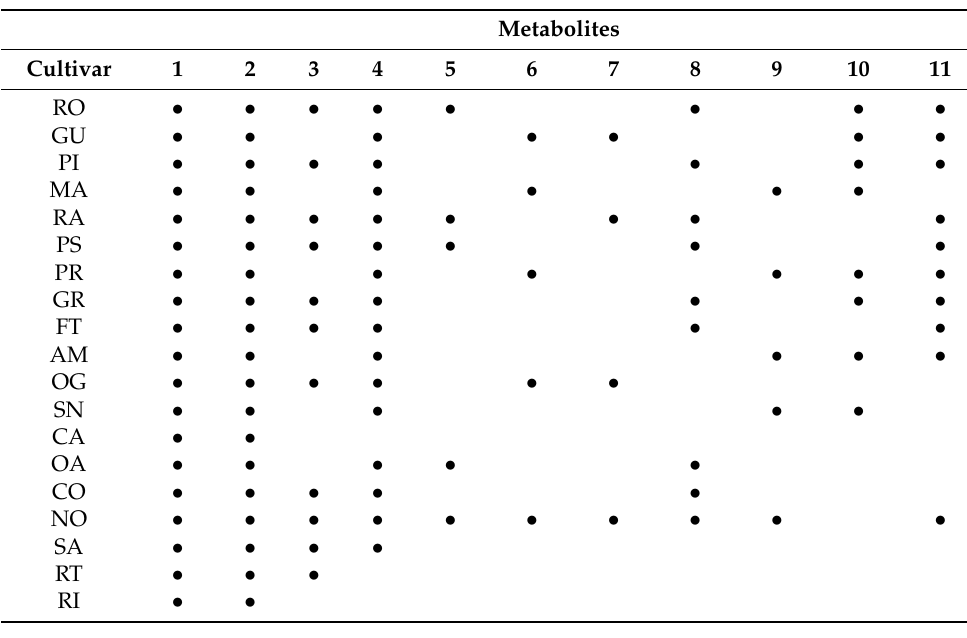
Table 3. Phytochemical compositions of the analyzed